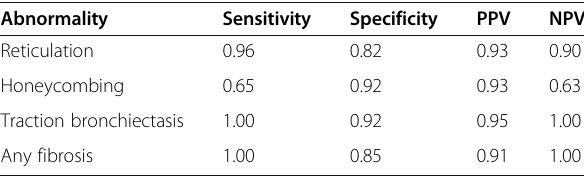
Table 4 Sensitivity, specificity, and predictive values of LGE-MRI in determining the presence of pulmonary abnormalities